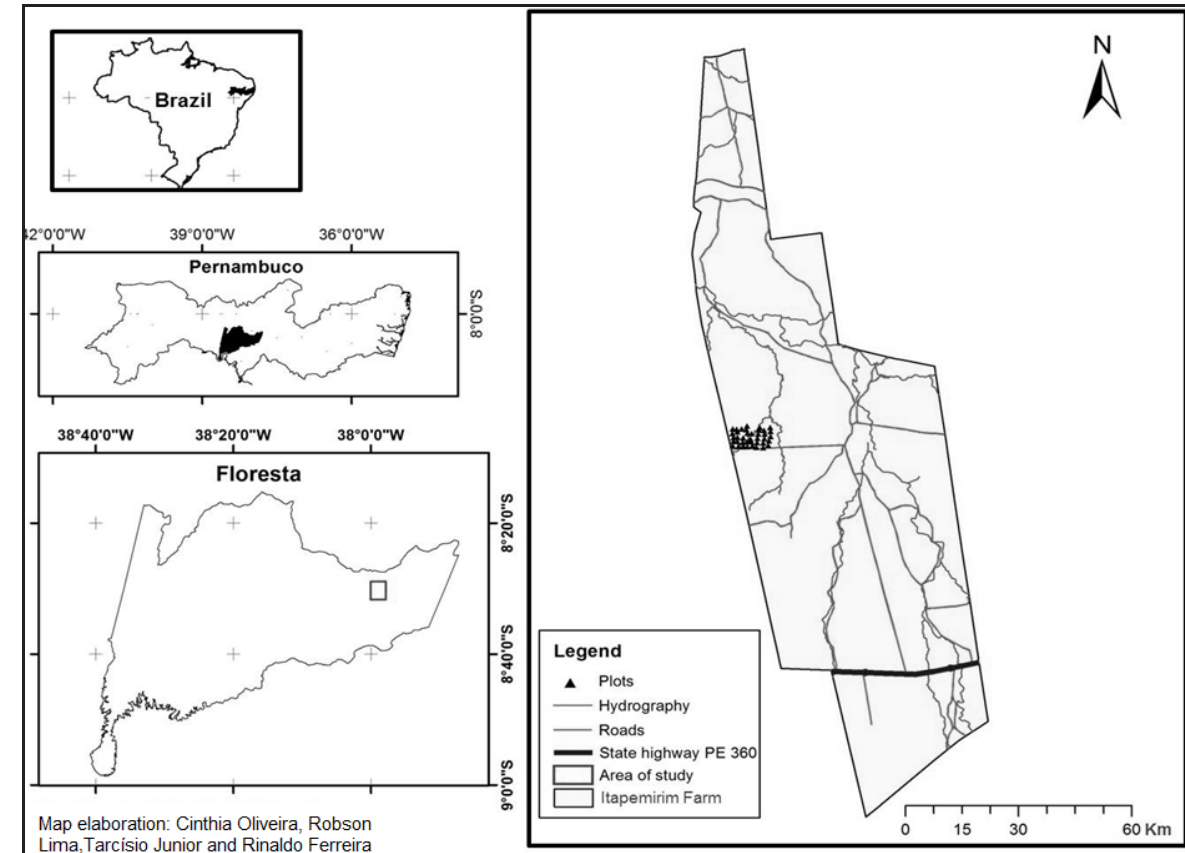
Figure 1 - Location of Itapemirim farm in Floresta city, Pernambuco,